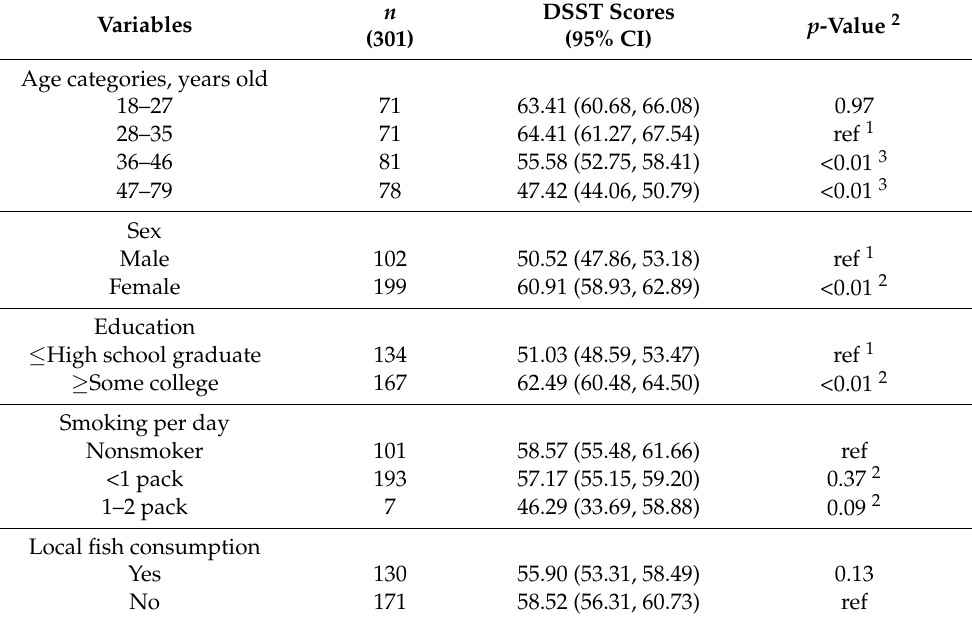
Table 1. Mean scores of DSST by demographic in Mohawk adults.